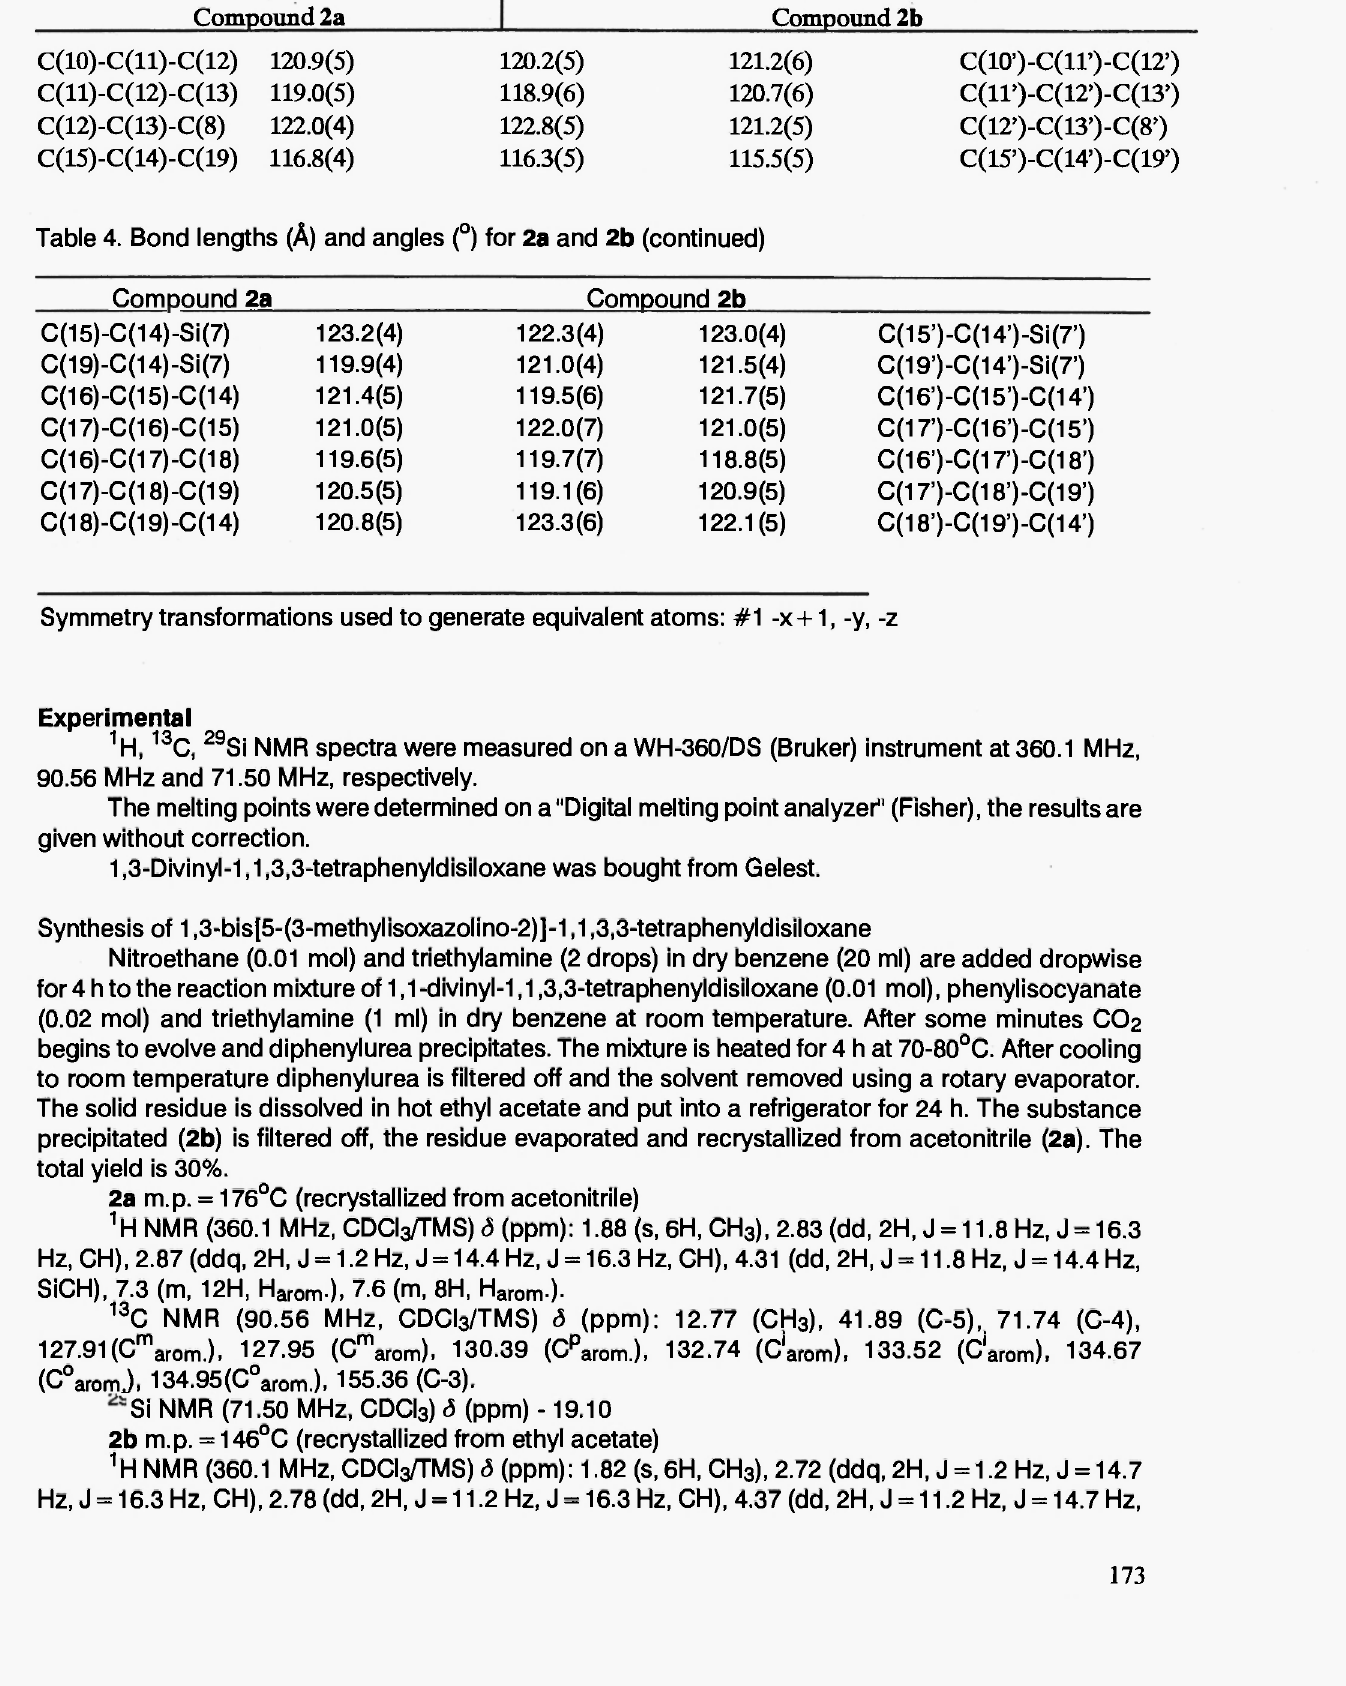
Table 4. Bond lengths (Ä) and angles (°) for 2a and 2b (continued) Compound 2a Compound